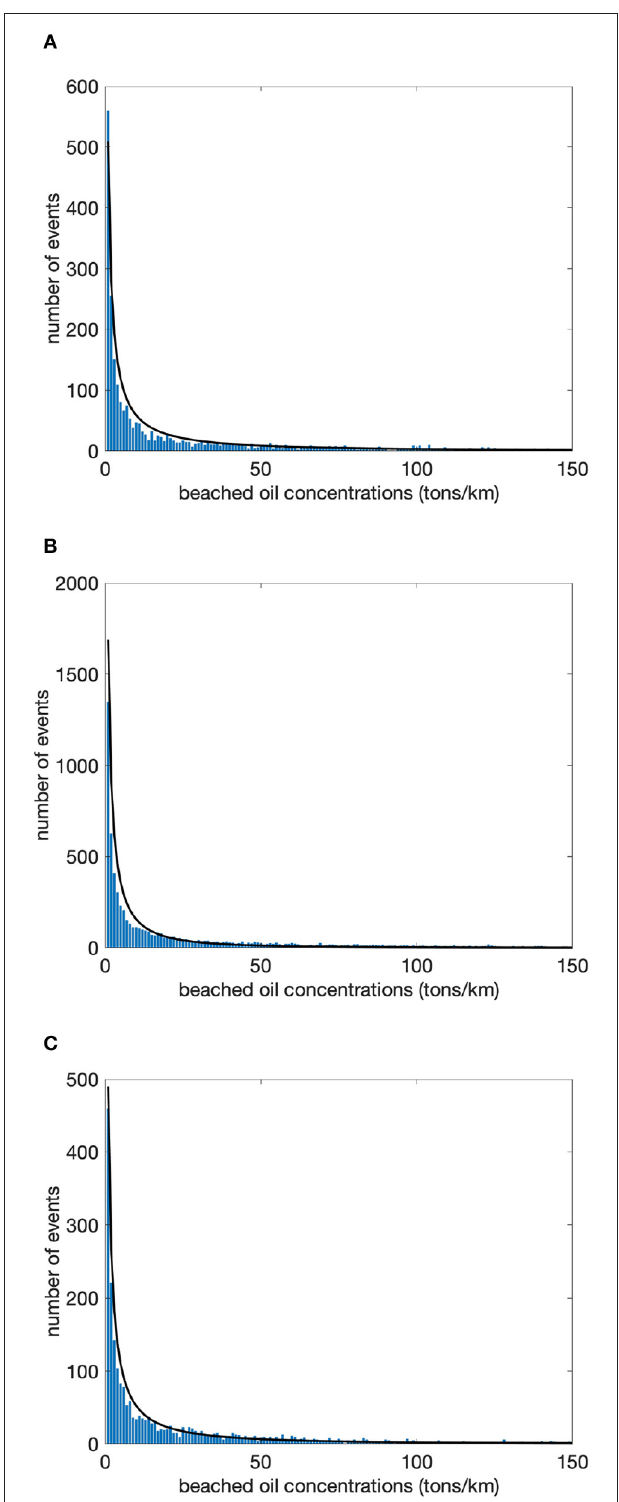
FIGURE 3 | Histogram (blue bars) and Weibull distribution function estimation (solid black line) of beached oil concentrations from the ensemble simulations for (A) the Eastern Atlantic Archipelago, (B) the Western Atlantic Island, and (C) coast of Bahia (Brazil).